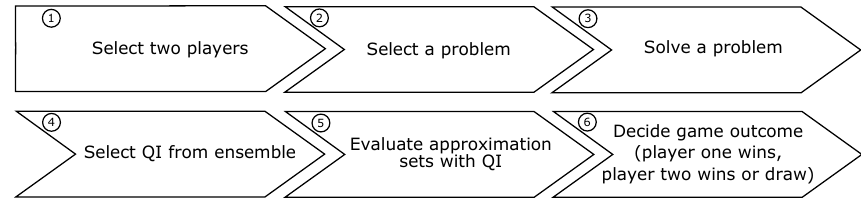
Figure 1. A single game in